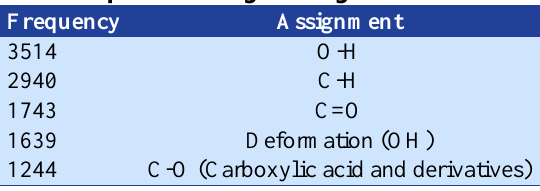
Figure 2. Reaction mechanism of grafting acrylic acid on gum tragacanth Table 3. Spectrum of gum tragacanth